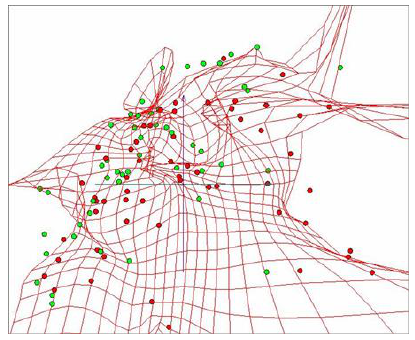
Figure 10. Elastic map for 10-dimensional attribute space